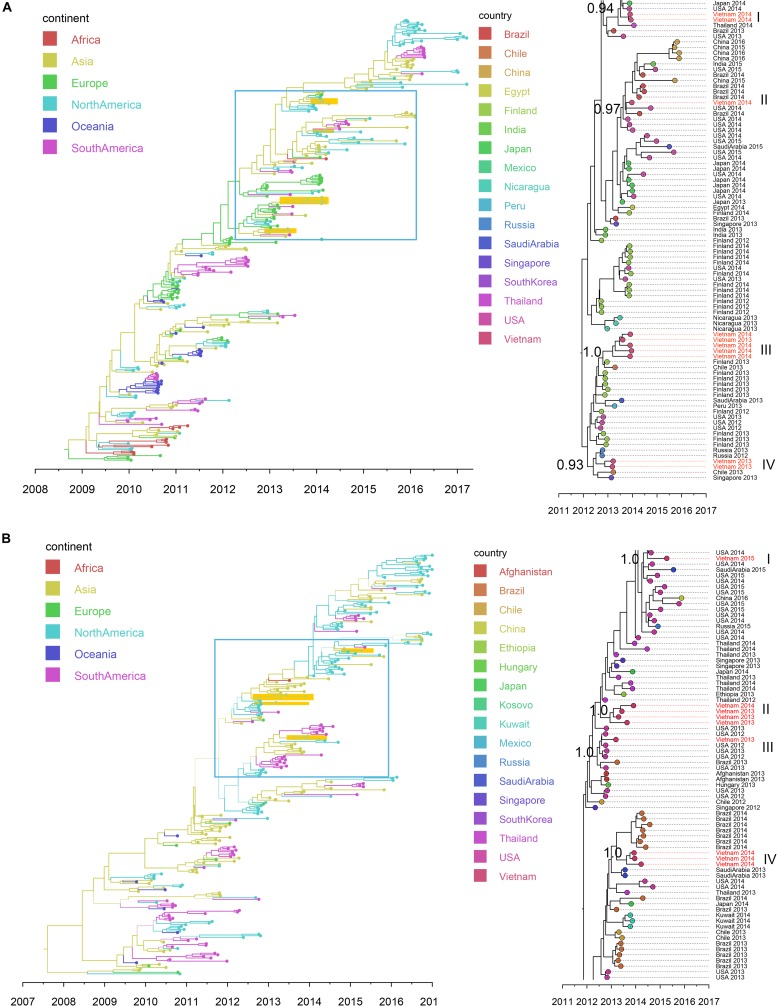
Bayesian MCC trees of IAV in Vietnam and worldwide using HA gene sequences isolated since 2009: (A) SwH1N1 (n = 296) and (B) H3N2 (n = 265). Branch colors represented the most probable ancestral locations of each branch, inferred using a discrete trait model; sequences from Vietnam (all available) were highlighted in orange. The clades containing Vietnamese sequences isolated in this study (within the box) are shown on the right, with tip nodes mapped to countries and isolate time (year), with Vietnamese strains highlighted in red, and labeled with subgroups and posterior support.